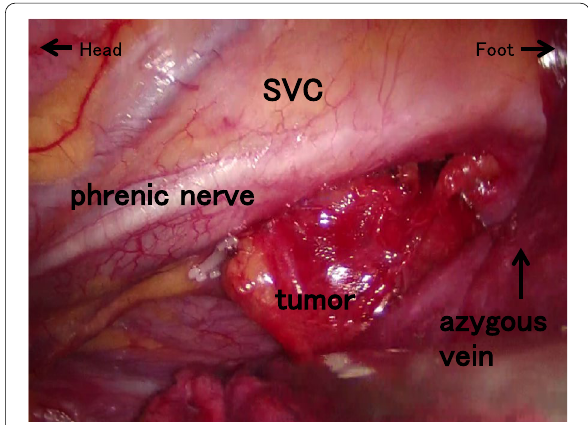
Fig. 4 An intraoperative image. The image shows a tumor in the middle mediastinum